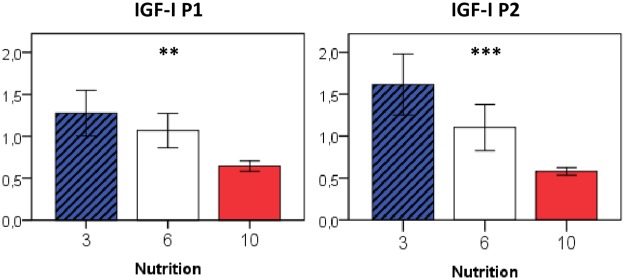
Relative gene expression of IGF-I in the liver at P50 in relation to early postnatal nutrition.If not indicated otherwise, displayed significance levels (** p<0.01, *** p<0.001) refer to comparisons between all three nutrition groups (ANOVA). n = 4–6 males per nutrition group.